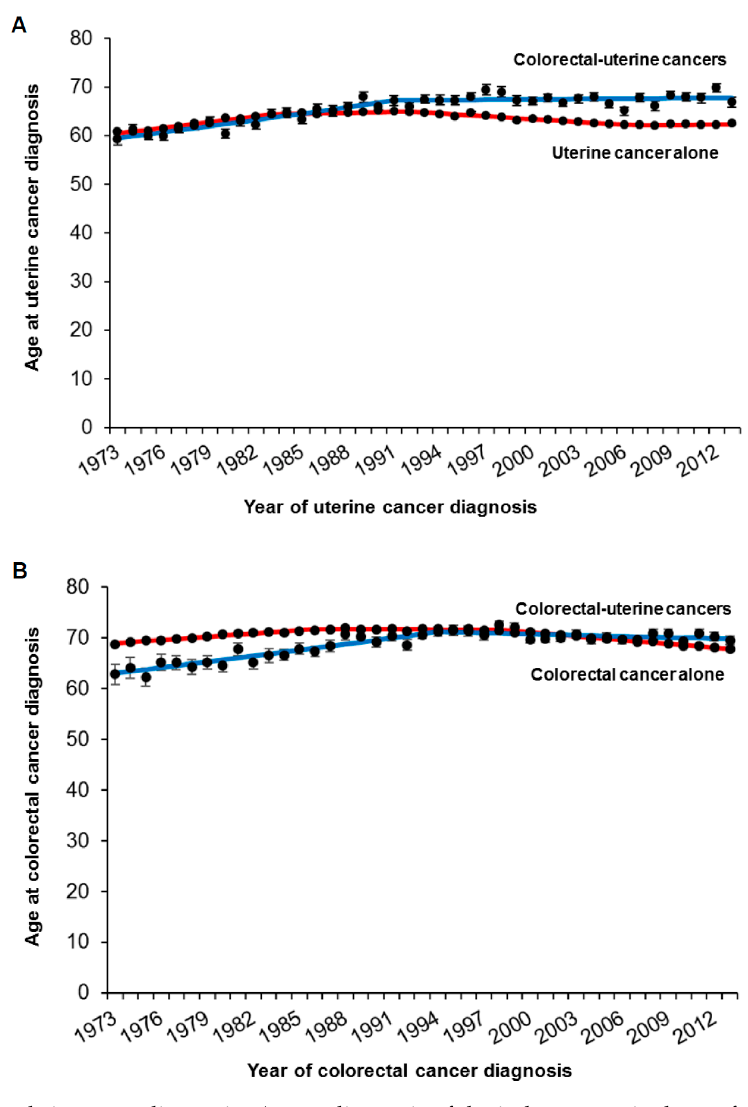
Figure 1. Trends in age at diagnosis. Age at diagnosis of the index cancer is shown for ( A ) uterine cancer cohort and ( B ) colorectal cancer cohort. Dots represent actual mean values. Bars represent standard errors. Colored lines represent modeled lines. Raw results of temporal trends are shown in Supplemental Table S3.